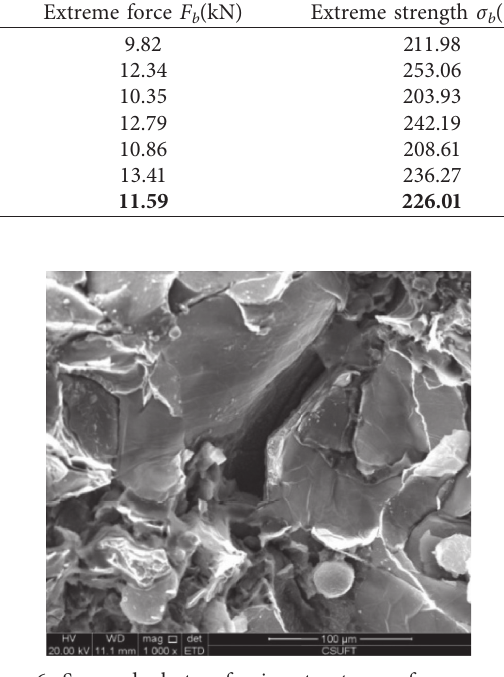
Figure 6: Scanned photo of microstructures of gray cast iron HT200 by